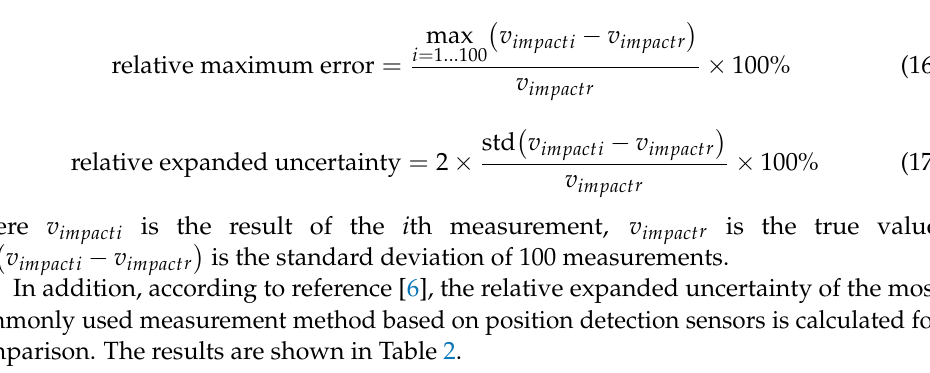
Table 2. Relative maximum error and relative expanded uncertainty of simulation measurement. Height/m